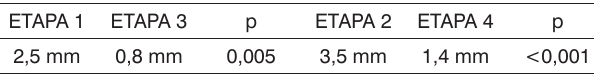
Tabela 1. Comparação das médias entre as etapas 1 (sem o siste- ma; tesoura parada) e 3 (com o sistema; tesoura parada no centro; fio esticado), e entre as etapas 2 (sem o sistema; abrindo e fechan-